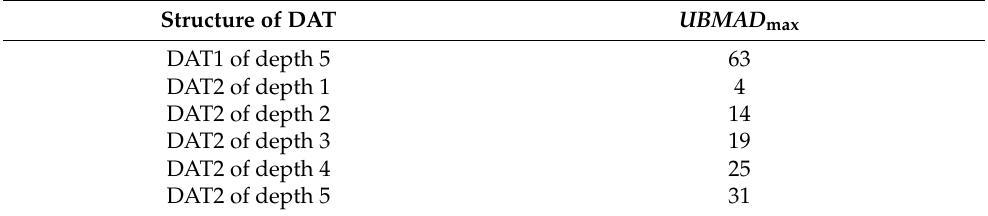
Table 8. Values of the parameter UBMAD max that provide the highest CR for each structure of DAT.